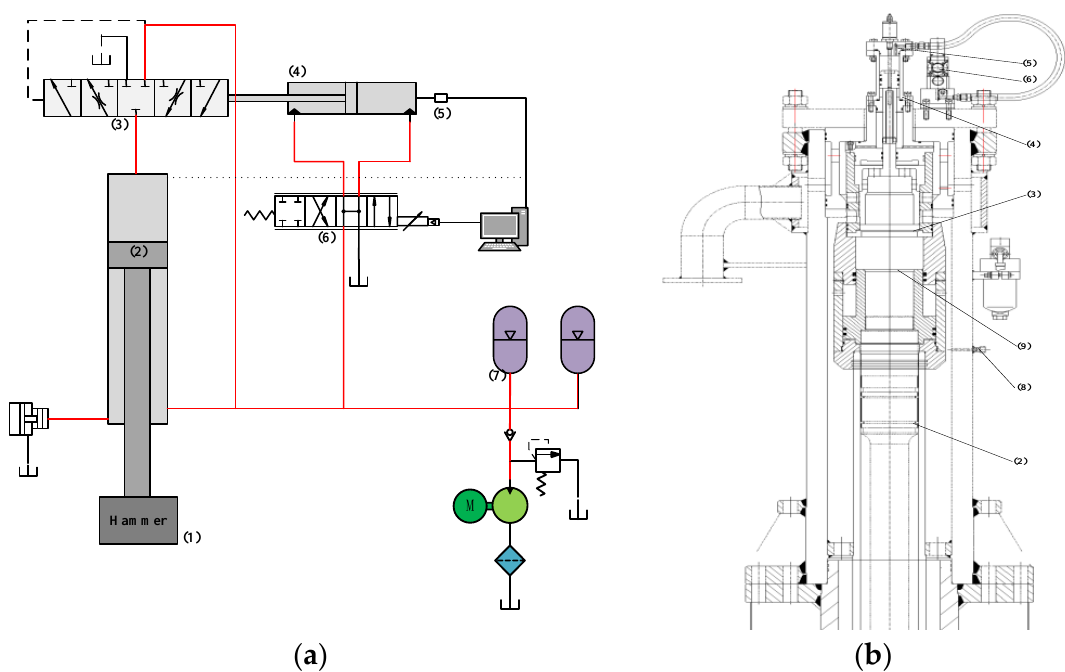
Figure 5. ( a ) Configuration of the proposed free forging hammer; ( b ) sectional view of the proposed hammer.